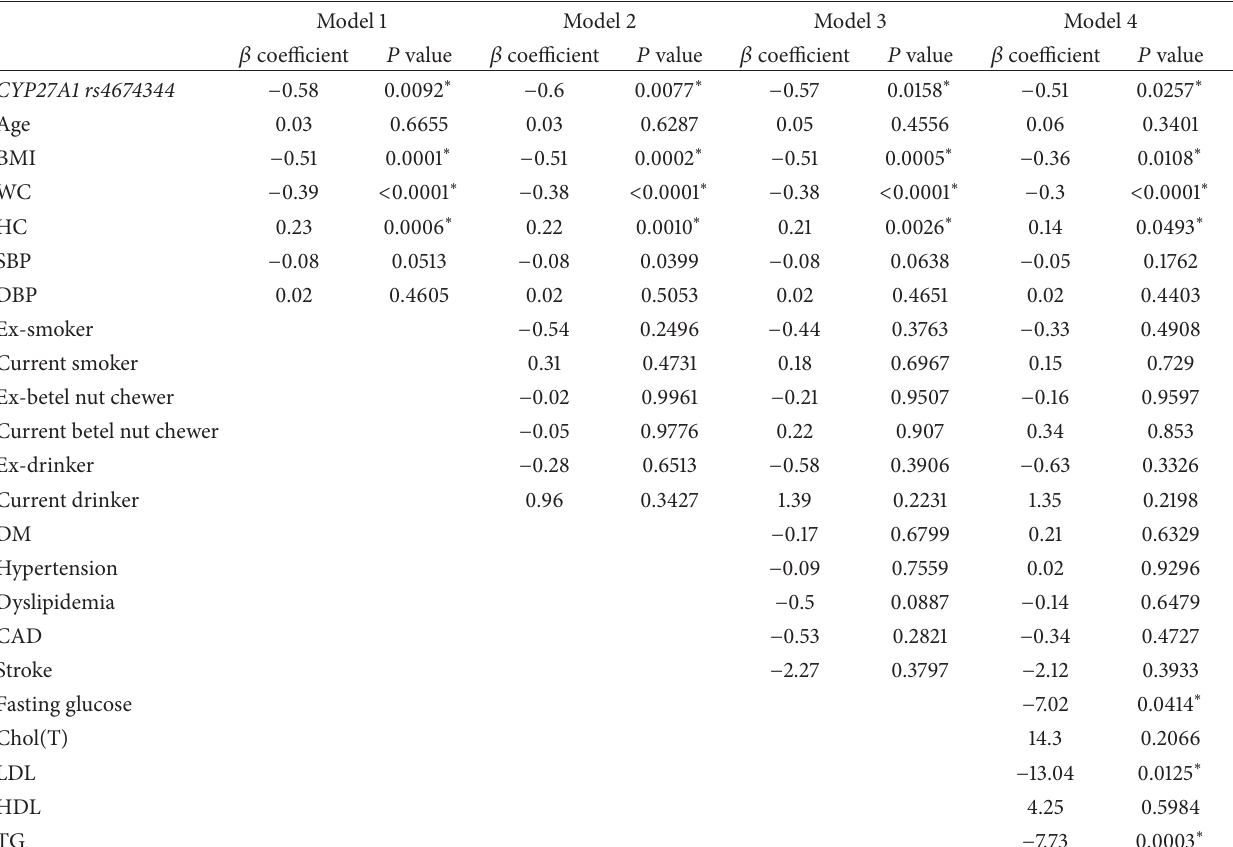
Table 3: 𝛽 coefficients between the CYP27A1 rs4674344 SNP and the adiponectin/leptin ratio.